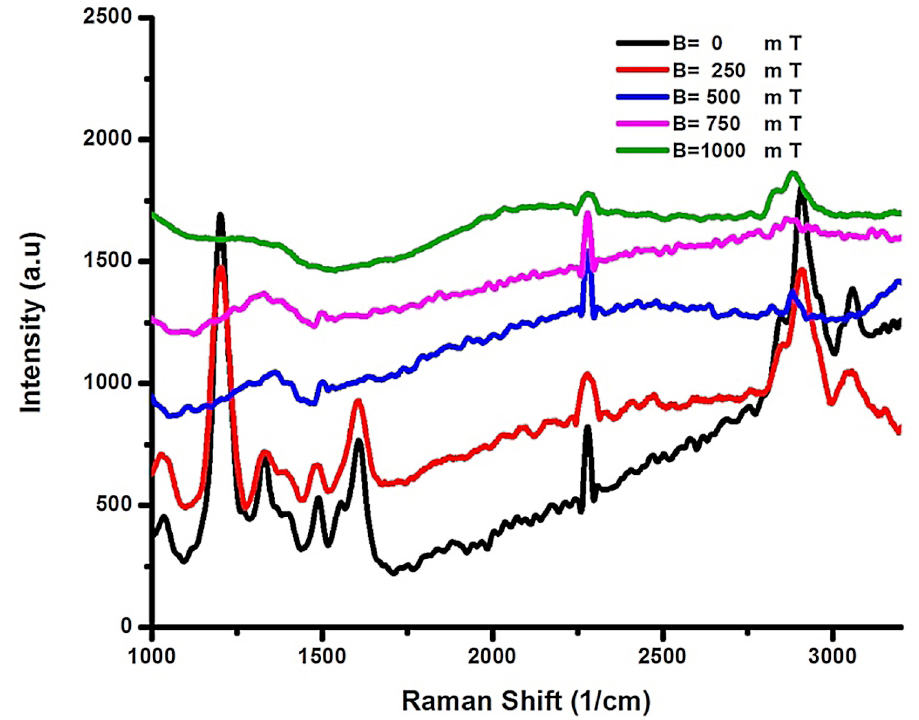
Fig 3. Raman spectra of CG 100. Raman spectra of CG 100 obtained using a 514 nm laser, before magnetic field exposure (B = 0) and after magnetic field (B = 250 mT, B = 500 mT, B = 700 mT and B = 1000 mT)